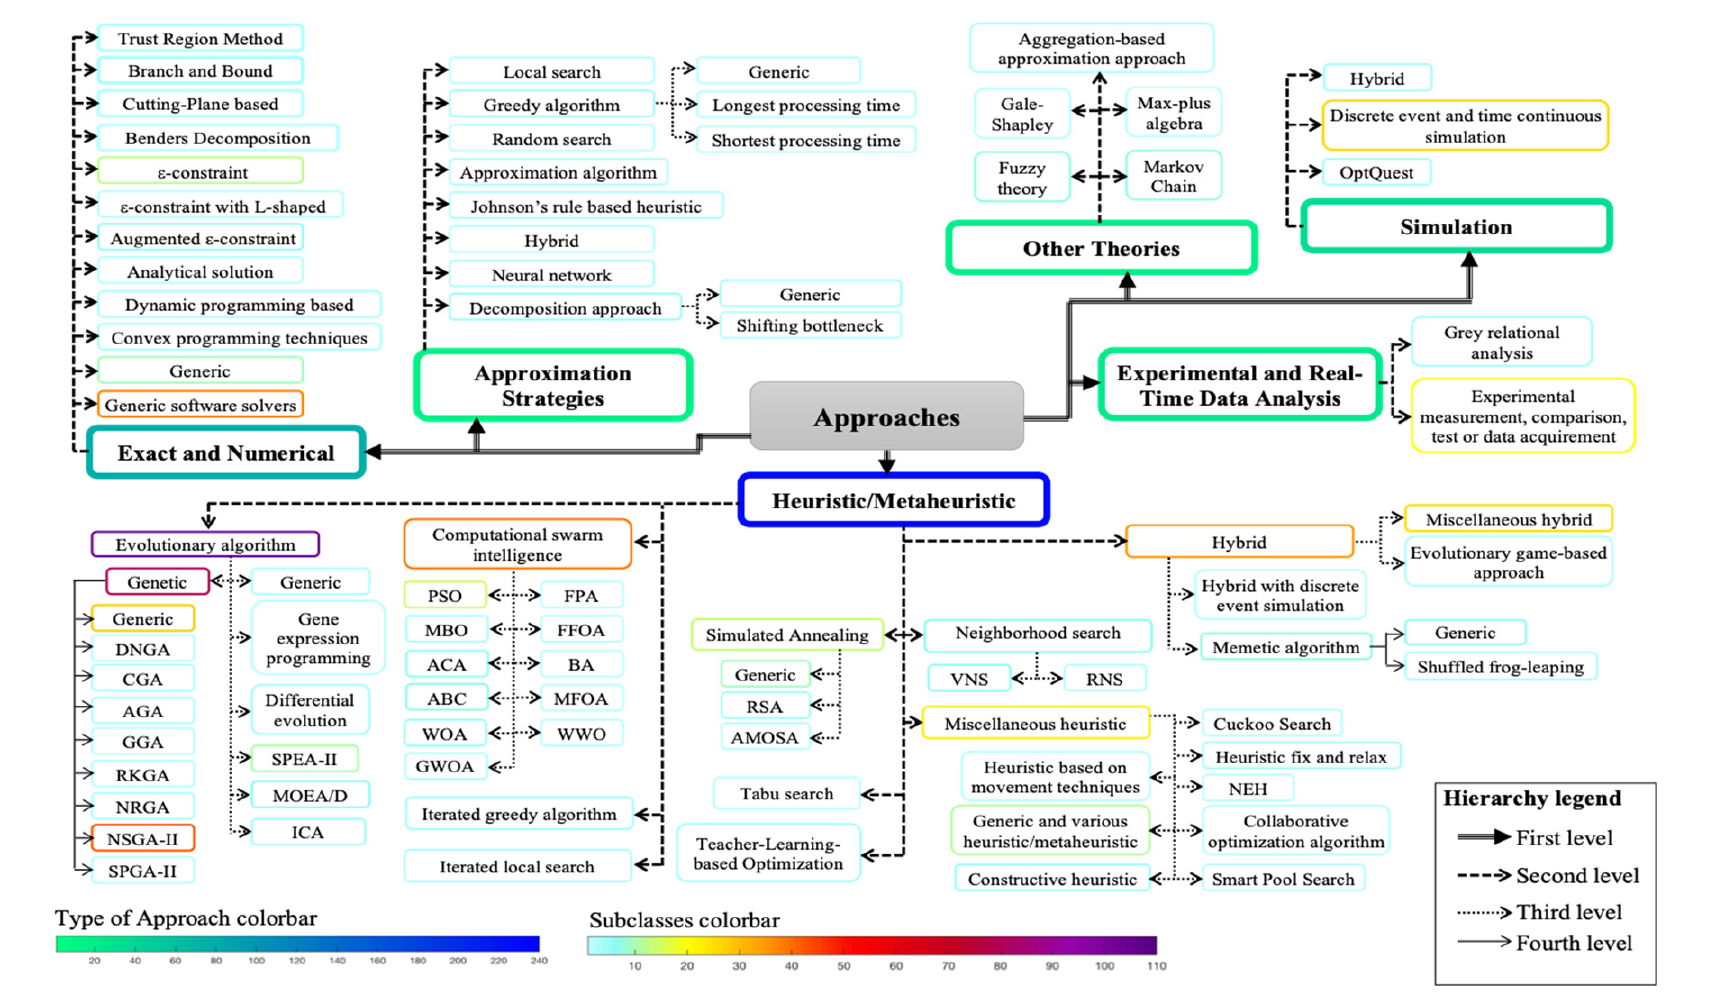
Figure 4. Energy efficient